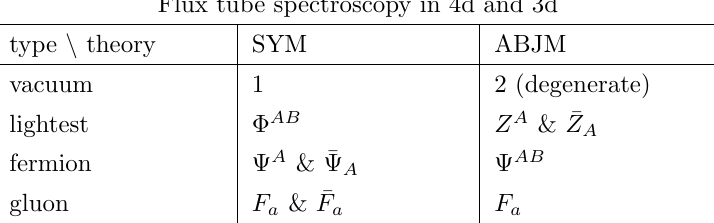
Table 1 . Flux tube excitations in 4d and 3d and their